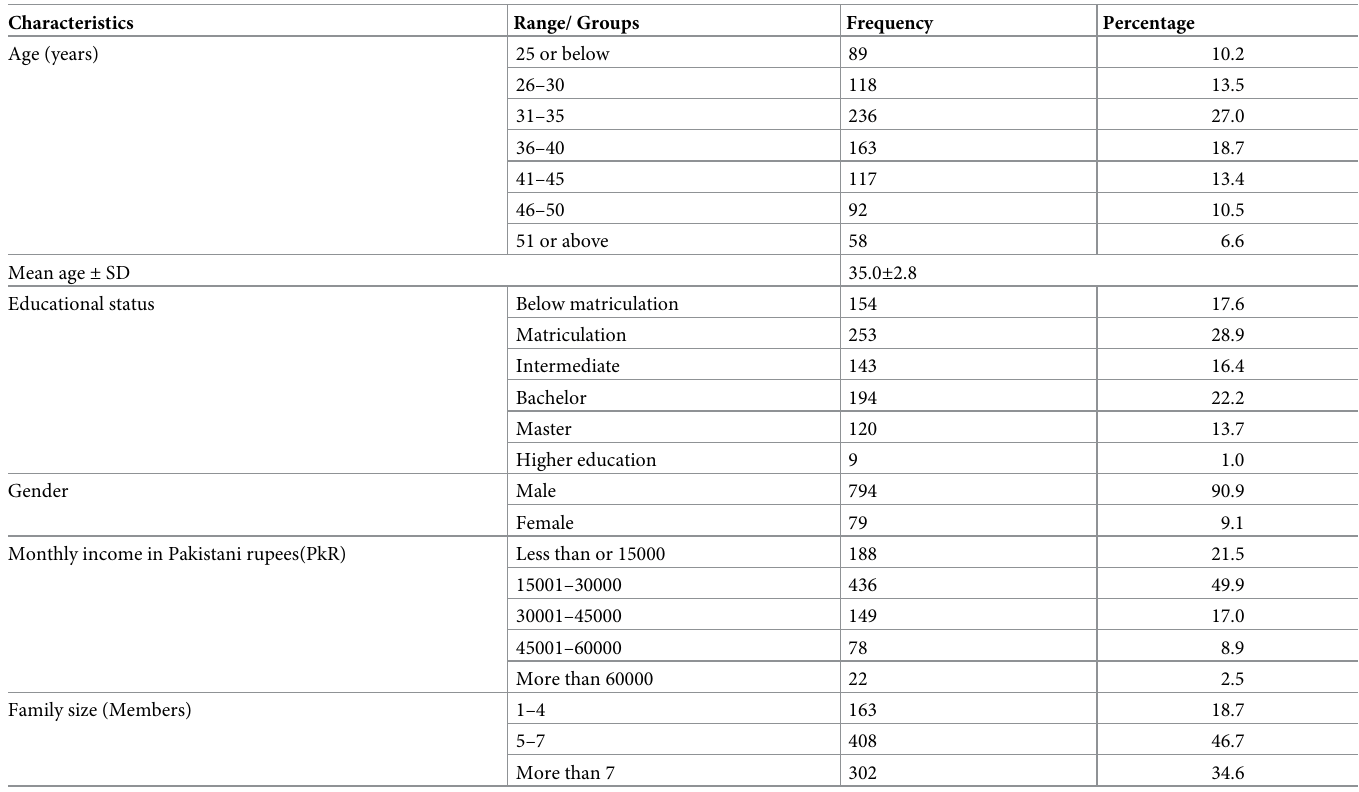
Table 2. Socio-demographic characteristics of participants (n = 873).